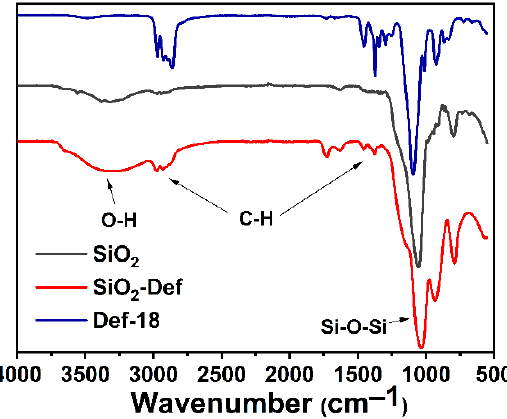
Figure 6. FT-IR spectra of SiO 2 , Def-18, and SiO 2 -Def.